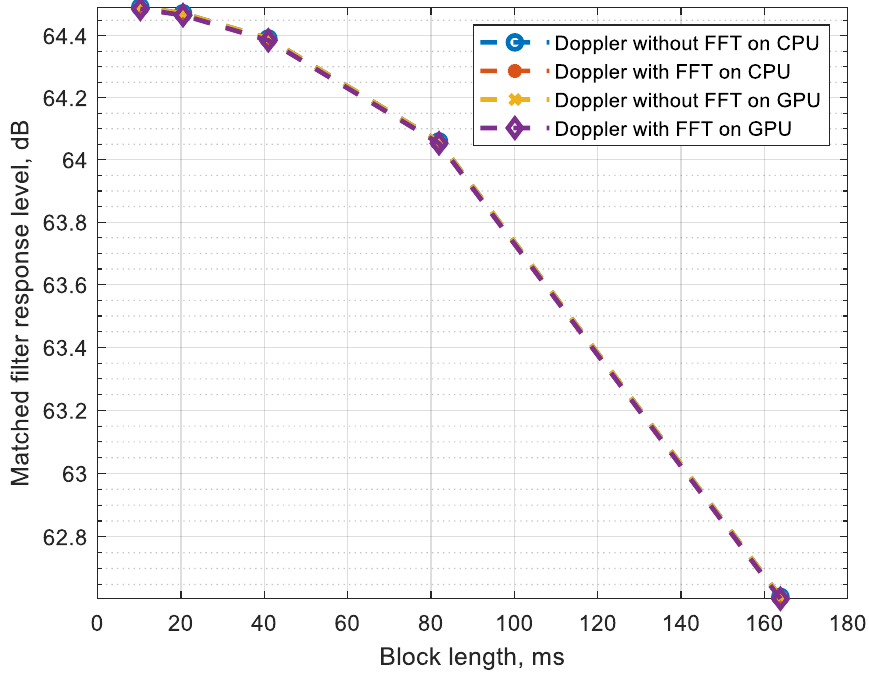
Figure 11. Dependence of the response level of the matched filter on the duration of the block with a Doppler frequency shift f d = 3